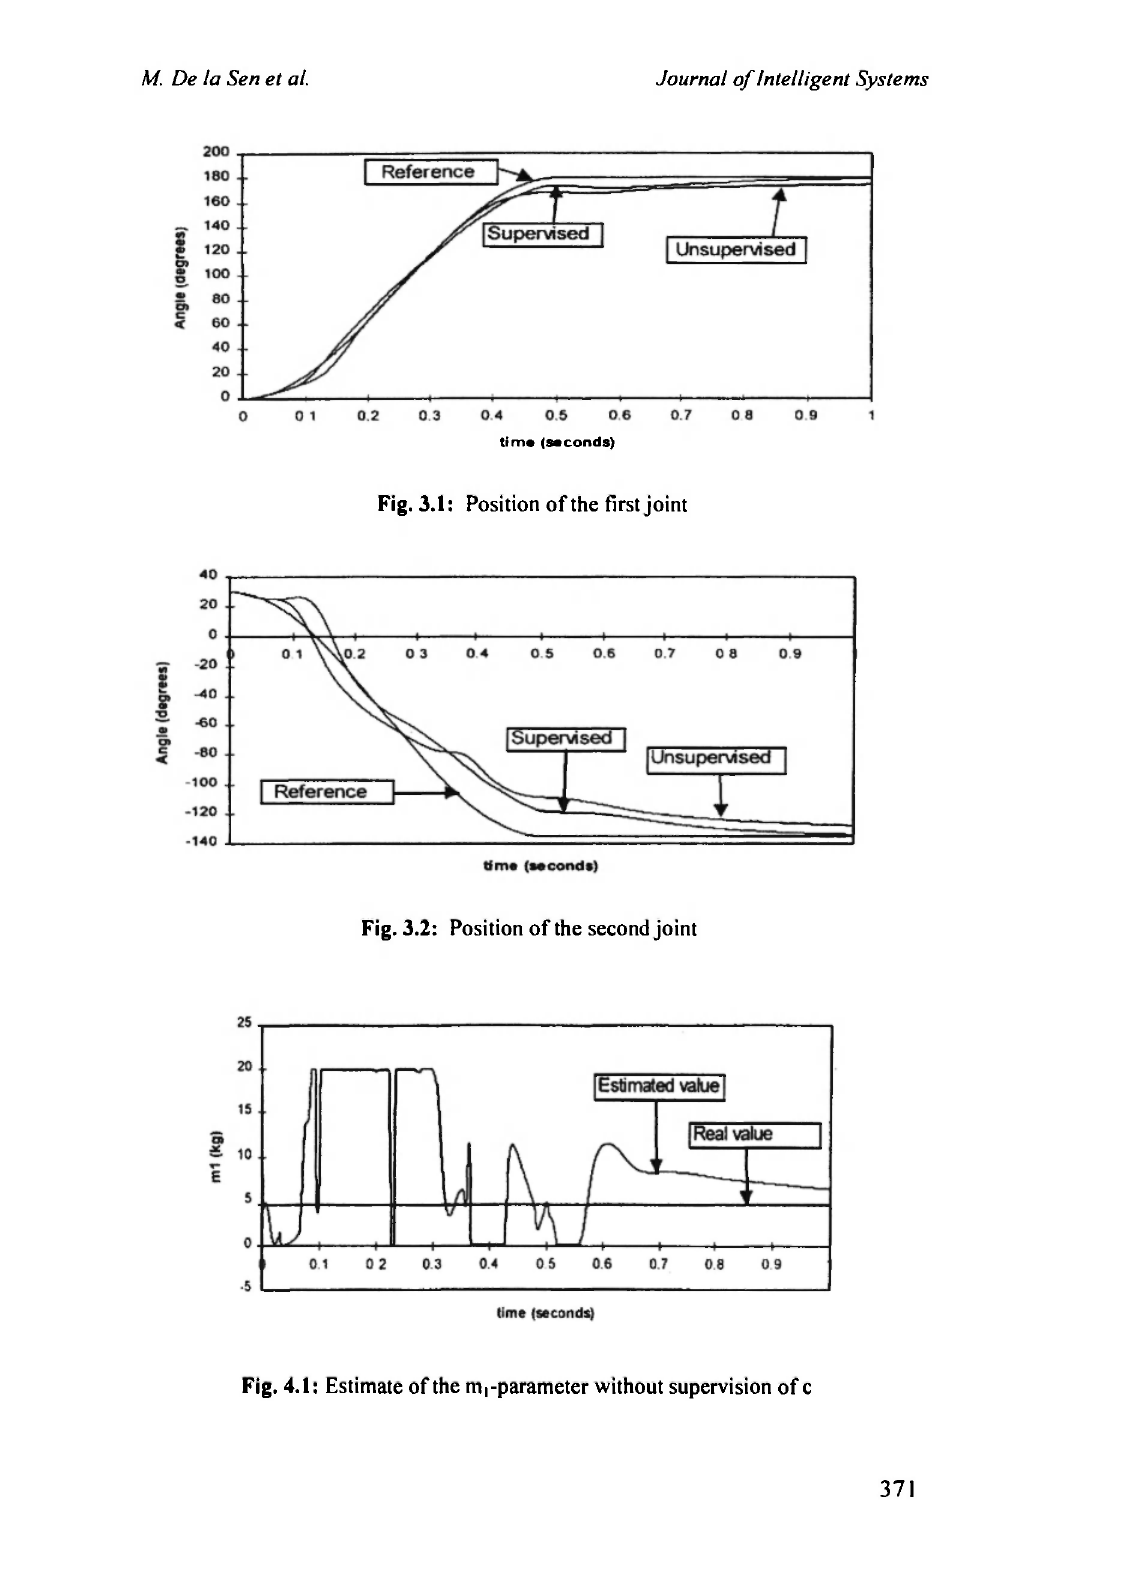
Fig. 4.1: Estimate of the ni|-parameter without supervision of c